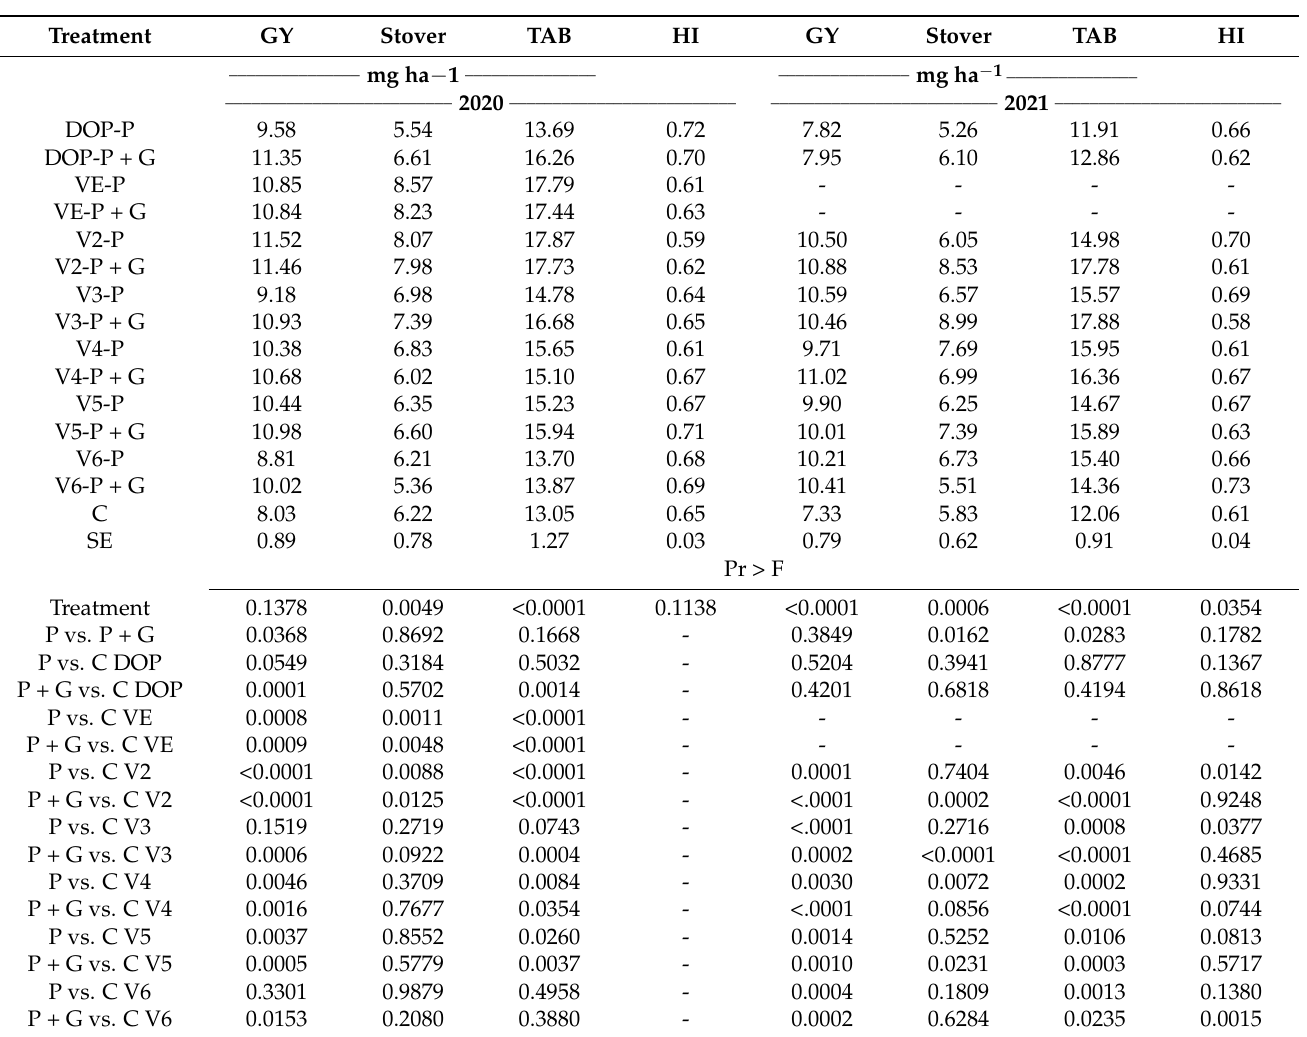
Table 4. Treatment means and significance for maize measurements, including grain yield (GY), stover yield (Stover), total aboveground biomass (TAB), and harvest index (HI), at Sorenson Research Farm in 2020 and 2021. Grain yield was obtained from hand and combine harvest and is expressed at 150 g kg − 1 moisture content. Total aboveground biomass, stover yield, and HI are expressed on an oven-dry